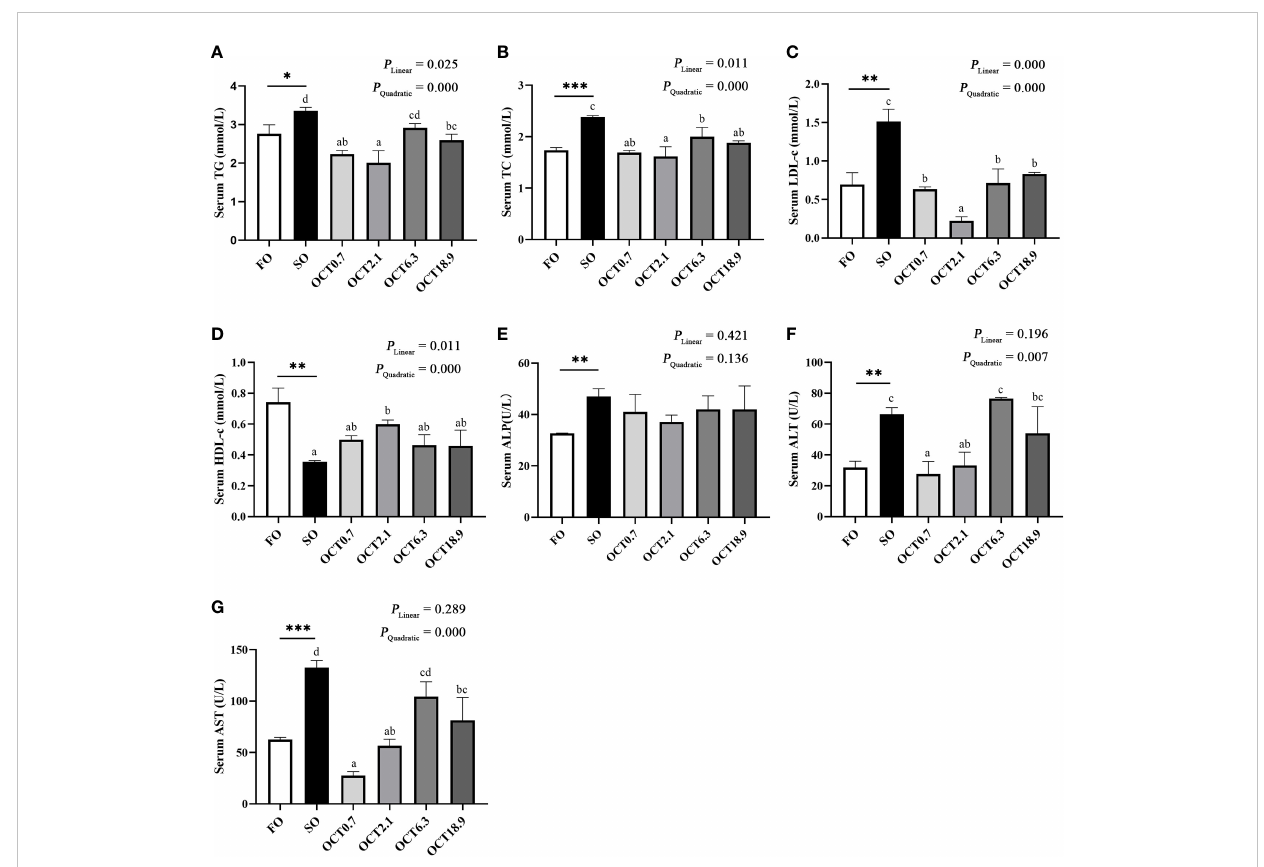
FIGURE 3 Effects of supplemental octanoate on serum biochemical indexes of large yellow croaker. (A) Serum TG contents, (B) Serum TC contents, (C) Serum LDL-c contents, (D) Serum HDL-c contents, (E) Serum ALP activity, (F) Serum ALT activity, (G) Serum AST activity. Values were means (n = 3) with their standard errors represented by vertical bars. ∗ represent a signi fi cant difference of P < 0.05 between the SO group and the FO group. ∗∗ represent a signi fi cant difference of P < 0.01 between the SO group and the FO group. ∗∗∗ represent a signi fi cant difference of P < 0.001 between the SO group and the FO group. Different letters show signi fi cant difference ( P < 0.05) among OCT treatment groups. Linear trend and Quadratic trend were analyzed by orthogonal polynomial